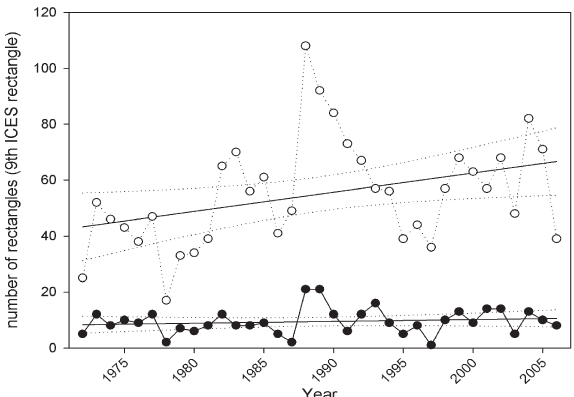
F IG . 3. – Number of rectangles (rectangles of 10*10 nm) which constitute the 50% (dark circles) and 90% (clear circles) highest abundance values observed for herring larvae per year. Lines denote regression with 95% confidence intervals. The increasing trend of the 90% line is statistically significant